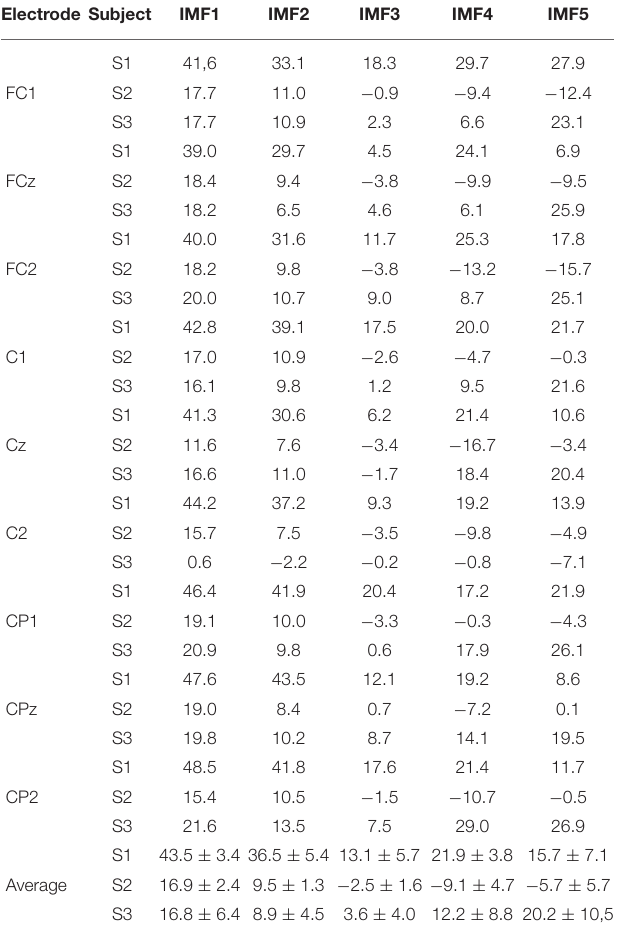
TABLE 3 | Comparison between the averaged 1 P ( % ) calculated using EMD and signal filtering by a second order Butterworth